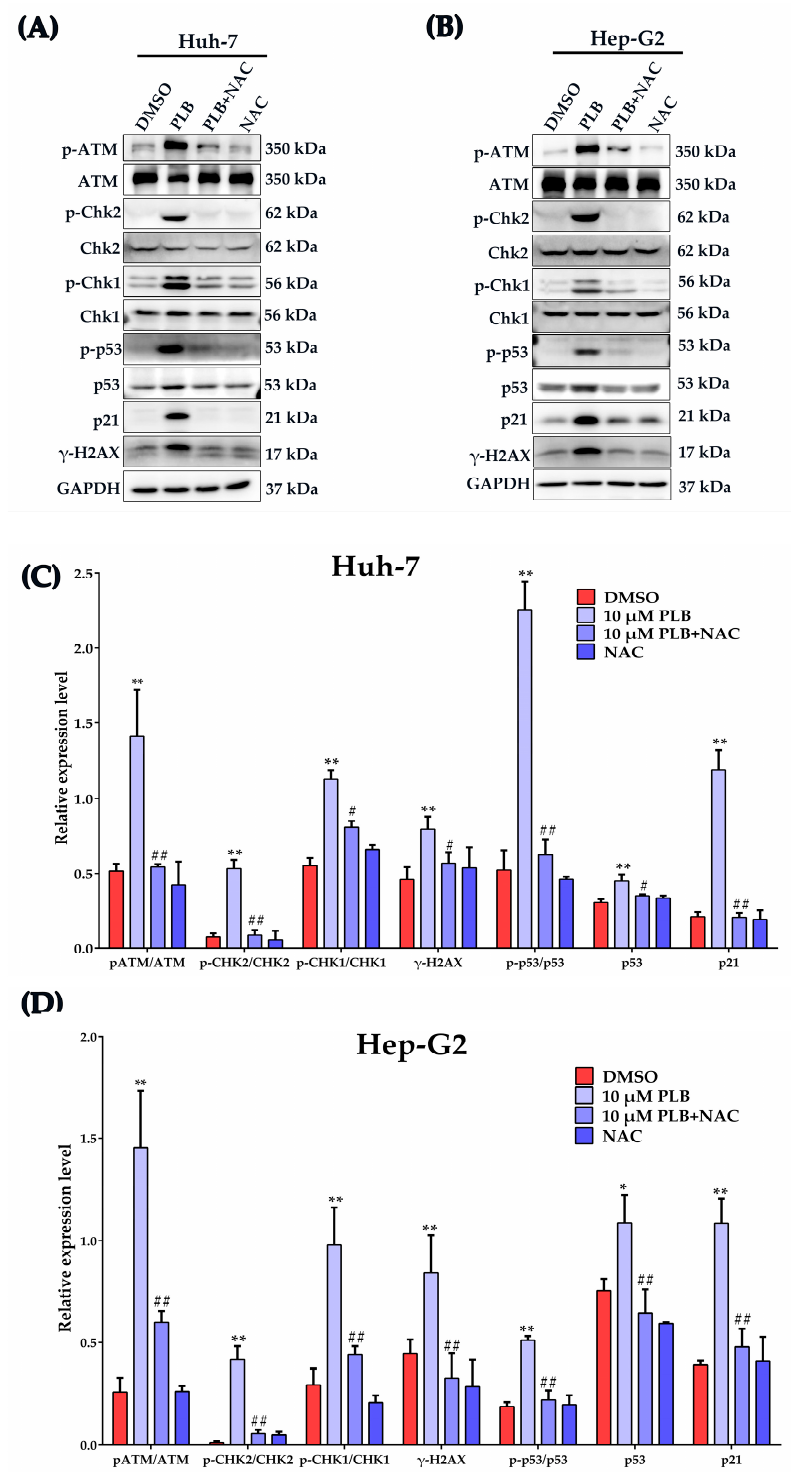
Figure 8. Activation of DNA damage response was inhibited by NAC pretreatment. HCC cells were pretreated with NAC (10 mM) or not for 1 h, and 10 µM of PLB was added into the medium for 12 h. ( A , B ) The expression of ATM, p-ATM (Ser1981), Chk2, p-Chk2 (Thr68), Chk1, p-Chk1 (Ser345), p53, p-p53 (Ser15) and p21 were determined by Western blot analysis. ( C , D ) Gray value statistical analysis of the indicated proteins. * p < 0.05, ** p < 0.01 compared to the DMSO group, # p < 0.05, ## p < 0.01 compared to the PLB treatment group; three independent experiments were performed.